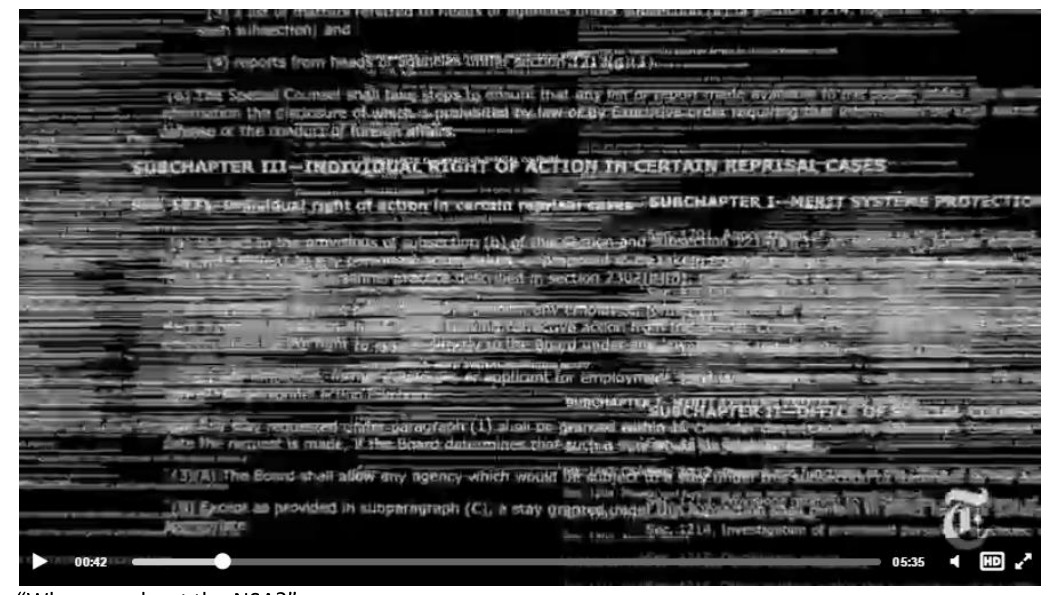
Figure 1. “Why care about the